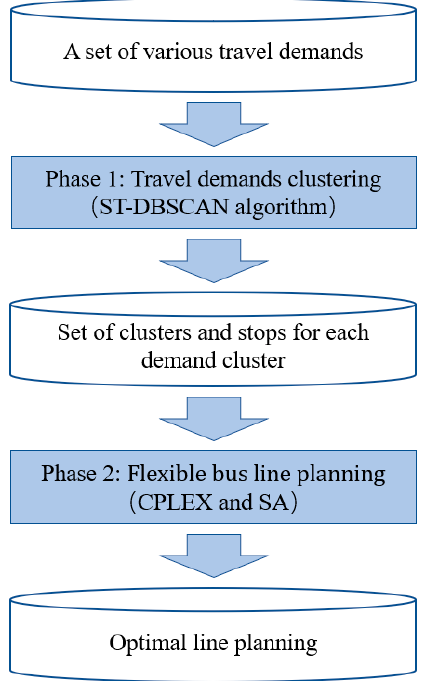
Figure 1. Framework of FB-routing system.